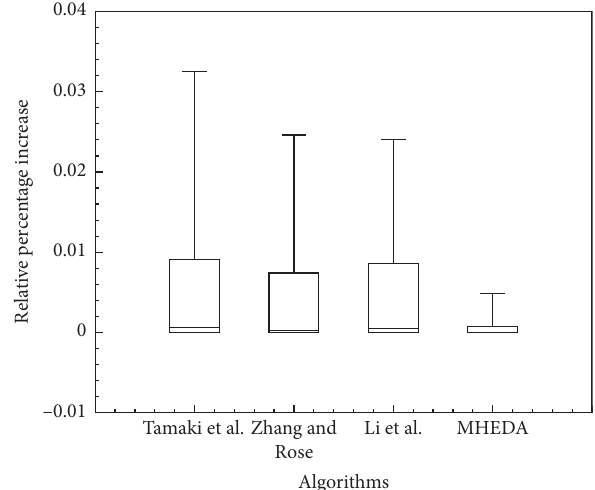
Figure 16: Comparative results for the MHSP using the relative percentage